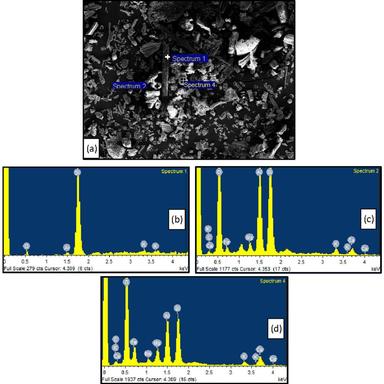
EDAX analysis of different shapes of particles in the SCBA (a) SEM image for EDAX analysis (b) Spectrum 1 – prismatic shaped particle, (c) Spectrum 2 – irregular shaped particle and (d) Spectrum 4 – Spherical shaped particle.